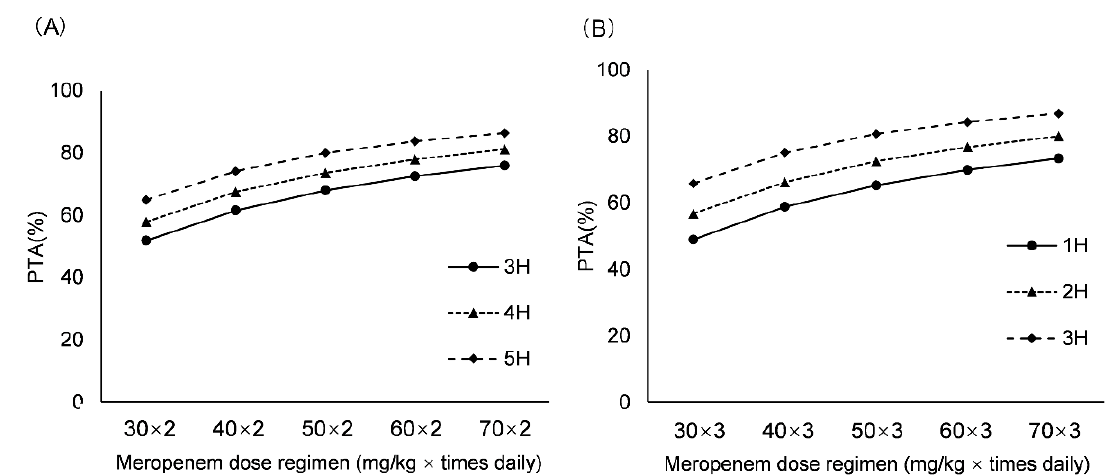
Figure 4. PTA of various dosing regimens for MIC value of 8 mg/L. ( A ) For newborns with GA ≤ 37 weeks; ( B ) For newborns with GA > 37 weeks. Probability of target attainment: PTA.